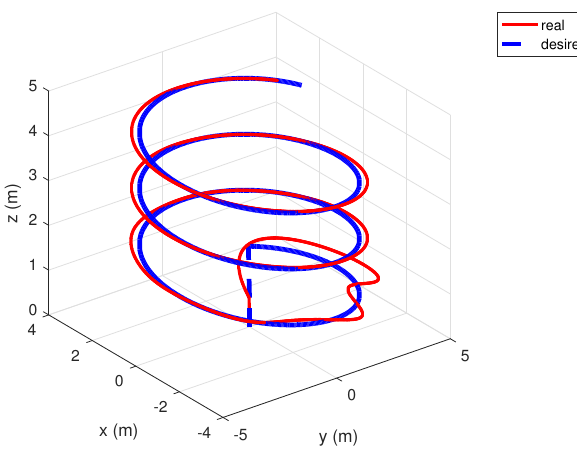
Figure 13. Three-dimensional